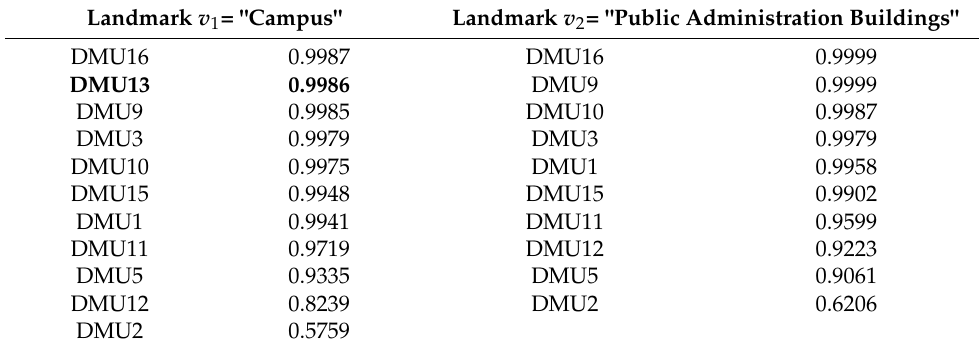
Table 2. DEA super-efficiency scores of optimal DMUs.